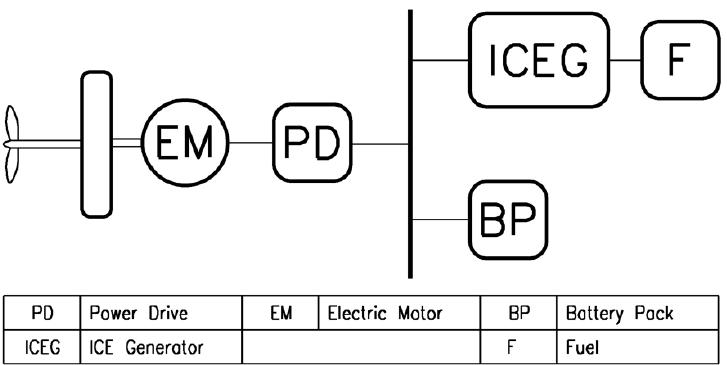
Figure 4. Electric propulsion, series configuration.